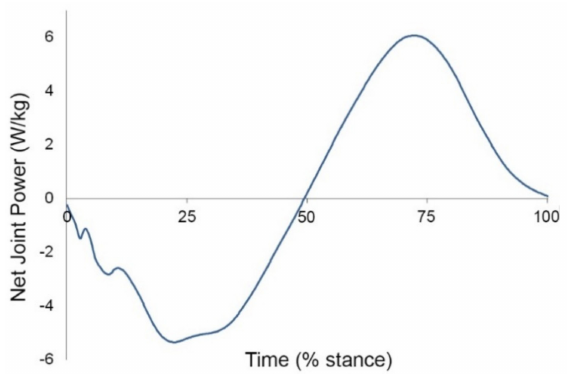
Figure 7. Net joint power curve for the fore fetlock joint at trot. Negative values indicate energy absorption, positive values indicate energy generation. The areas under the negative and positive parts of the curve indicate similar amounts of energy absorption in early stance and energy generation in late stance which is typical of elastic energy storage and release in the soft tissues [54].